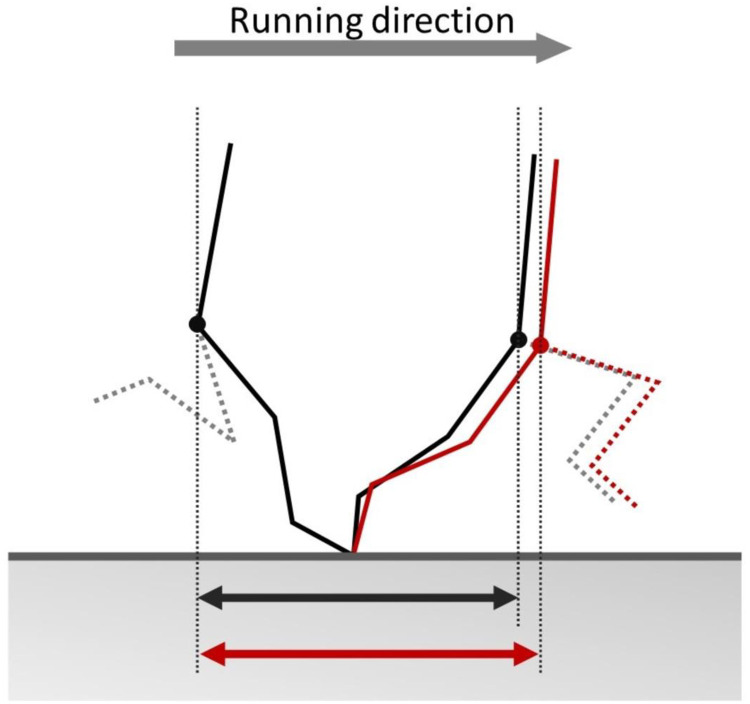
Schematic illustration of the body at touchdown and toe-off (modified from Ito et al. [30]).For a given degree of hip extension and ankle plantar flexion during the stance phase, a small degree of knee extension (red sticks) could result in a longer stance distance compared to a large degree of knee extension (black sticks).